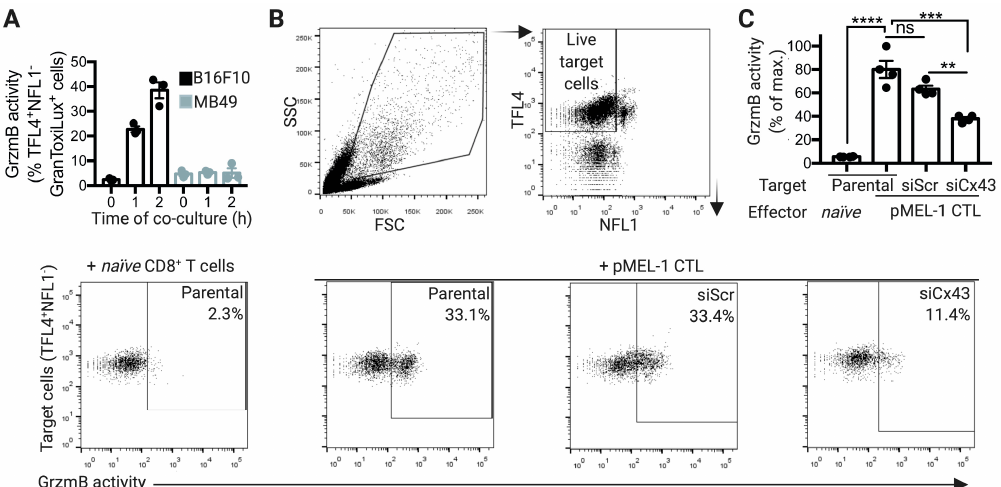
Figure 3. Connexin-43 gap junctions (Cx43-GJs) are required for granzyme b (GrzmB)-mediated cytotoxicity of pMEL-1 cytotoxic T lymphocytes (CTLs) against B16F10 melanoma cells. ( A ) B16F10 or MB49 cells were pre-stained with TFL4 (CellTracker) and NFL1 (viability marker) and co-cultured for different times (as indicated) with pMEL-1 CTLs, at a 1:5 ratio, in the presence of a permeable fluorogenic substrate for GrzmB (GranToxiLux; GrzmB activity). GrzmB activity was evaluated on TFL4 + NFL1 - target tumor cells by flow cytometry. ( B ) Representative dot plots showing the strategy for measuring GrzmB activity in target tumor cells co-cultured with effector cells. Target cells (parental, siScr- or siCx43-transfected B16F10) were pre-stained with TFL4 and NFL1 and co-cultured for 2 hours with effector cells (naïve CD8 + T cells or pMEL-1 CTLs), at a 1:5 ratio, in the presence of GranToxiLux substrate. The numbers in the dot plots represent the percentage of TFL4 + NFL1 - GranToxiLux + cells. ( C ) The bar graph shows the GrzmB activity in target tumor cells (TFL4 + NFL1 - GranToxiLux + ) as a percentage of the maximum (target tumor cell: parental/effector cell: pMEL-1 CTL); n = 4 independent experiments. ** p < 0.01; *** p < 0.001; **** p < 0.0001; ns = non-significant (one-way ANOVA, Tukey’s multiple comparison test).